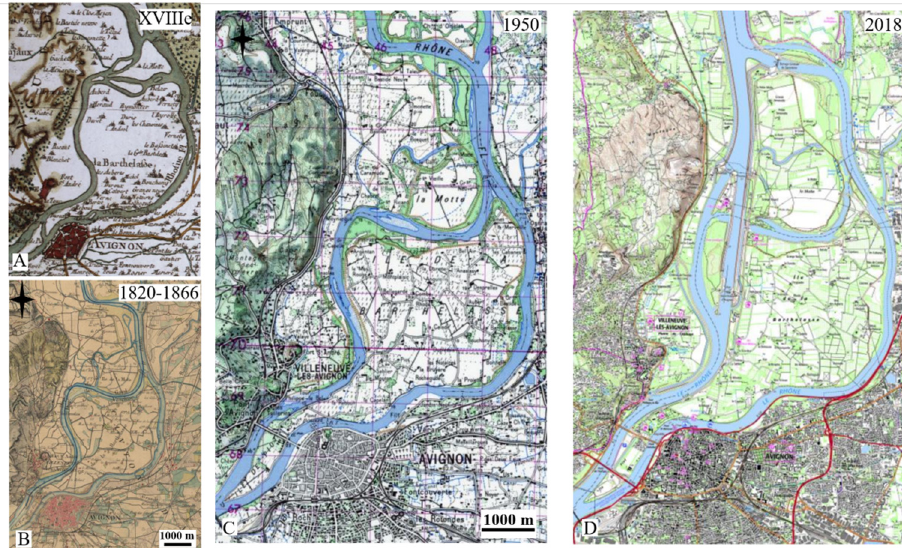
Figure 2. Time-lapse evolution of the Island of Barthelasse. ( A ) Extract of the first topographic card of the France Kingdom, “Carte Cassini”, from the XVIIIth Century. ( B ) Extract of the “carte d’Etat major” from 1820 to 1866. ( C ) Extract of IGN card from 1950. ( D ) Extract of IGN from